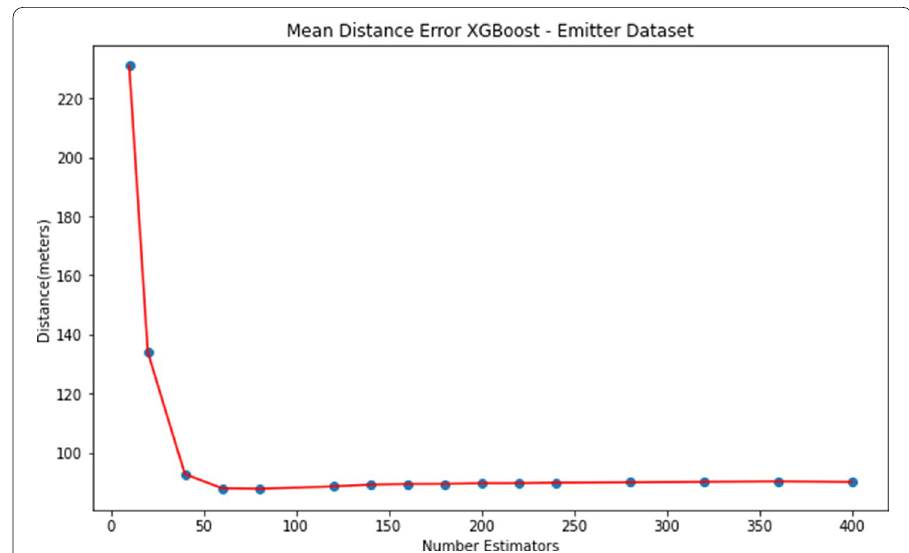
Fig. 13 Estimating model’s error on emitter dataset for